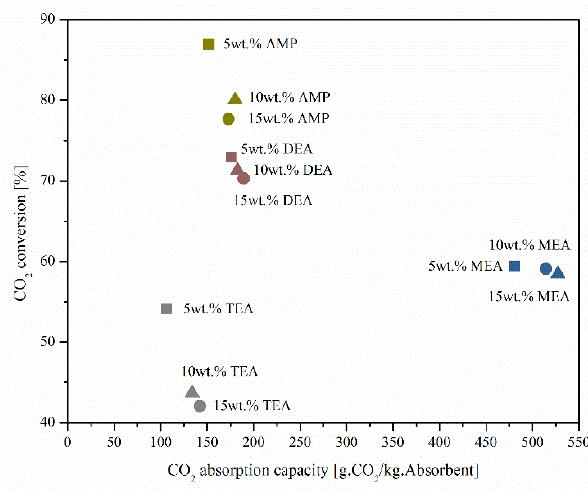
Figure 9. Correlation between amount of CO 2 absorption capacity and CO 2 conversion in 5, 10, and